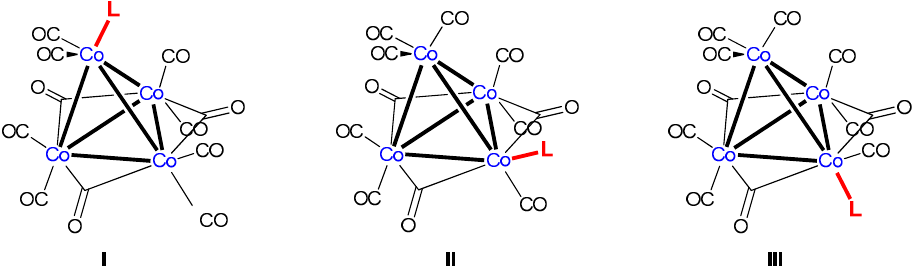
Figure 4. Presentation of the three conceivable isomers of [{Co 4 ( μ 2 -CO) 3 (CO) 8 L ] with L at the apical ( I ), equatorial ( II ), or axial site ( III ). ( I ), equatorial ( II ), or axial site ( III ).